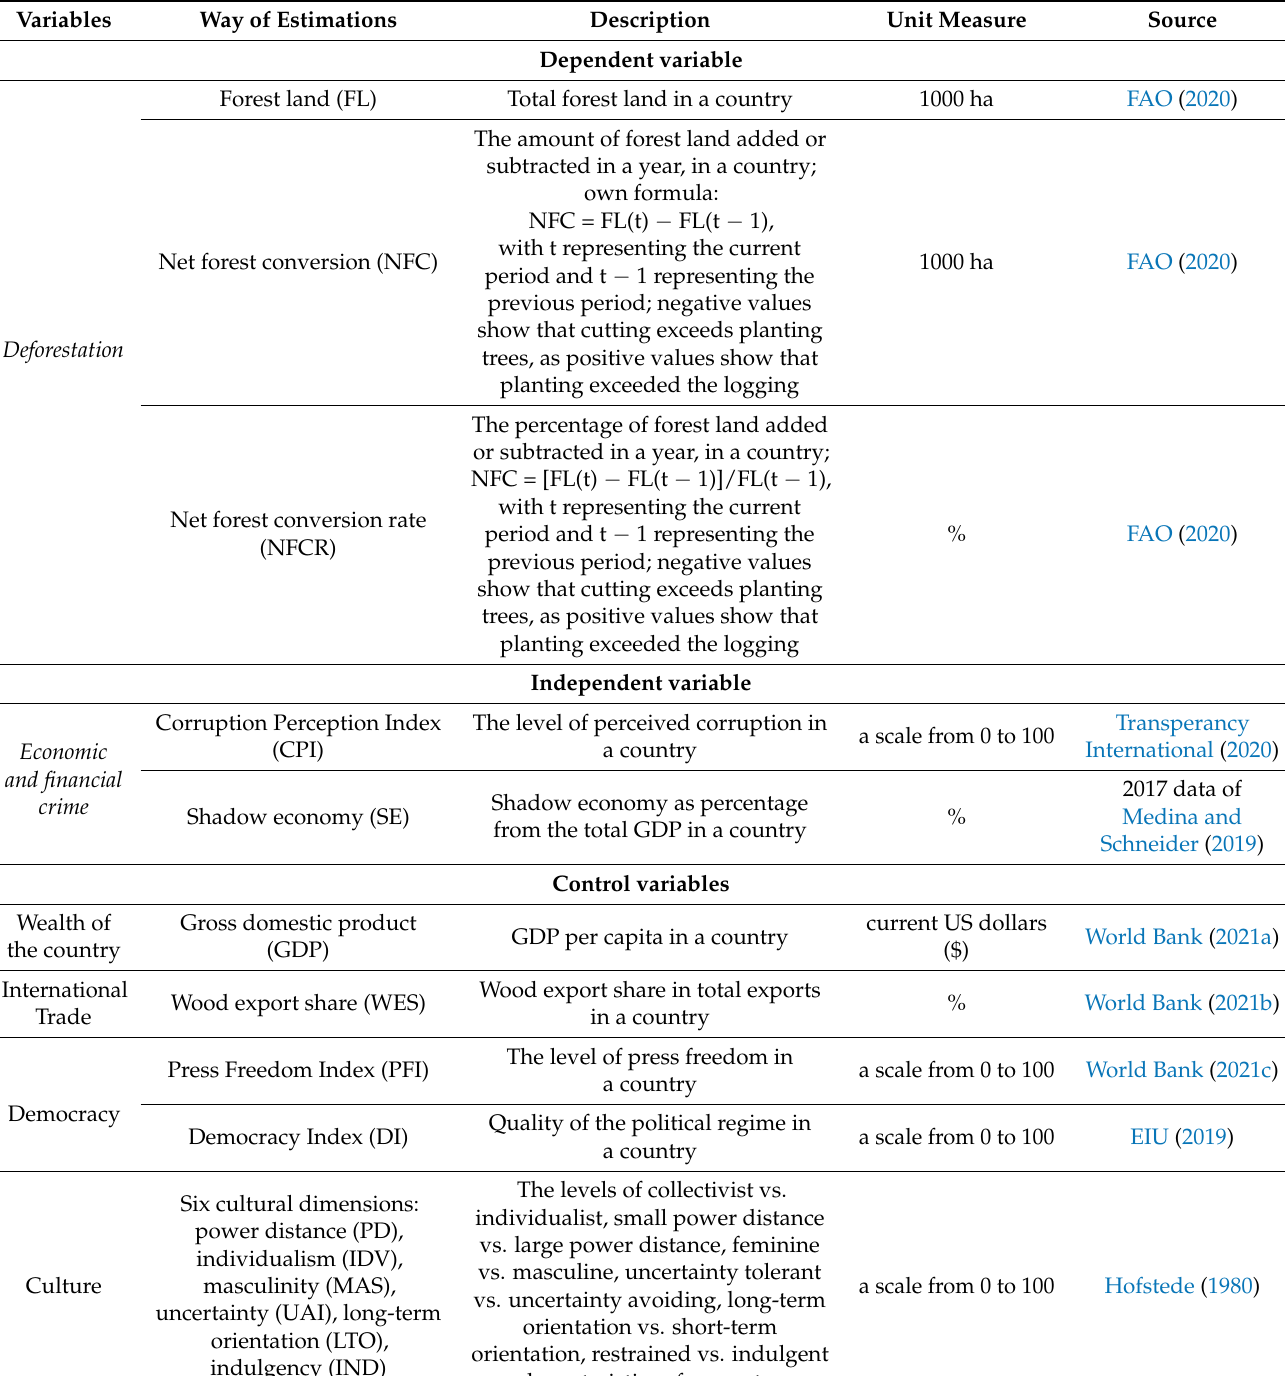
Table 2. Types of variables and data